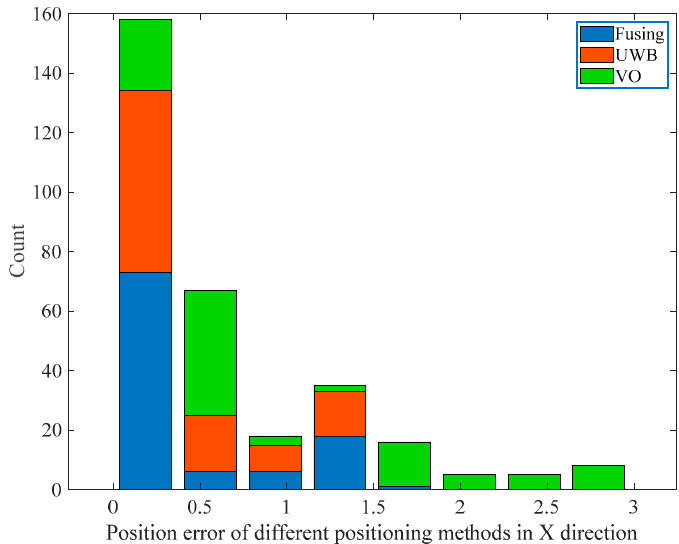
Figure 13. Position error distribution histogram in the X direction.